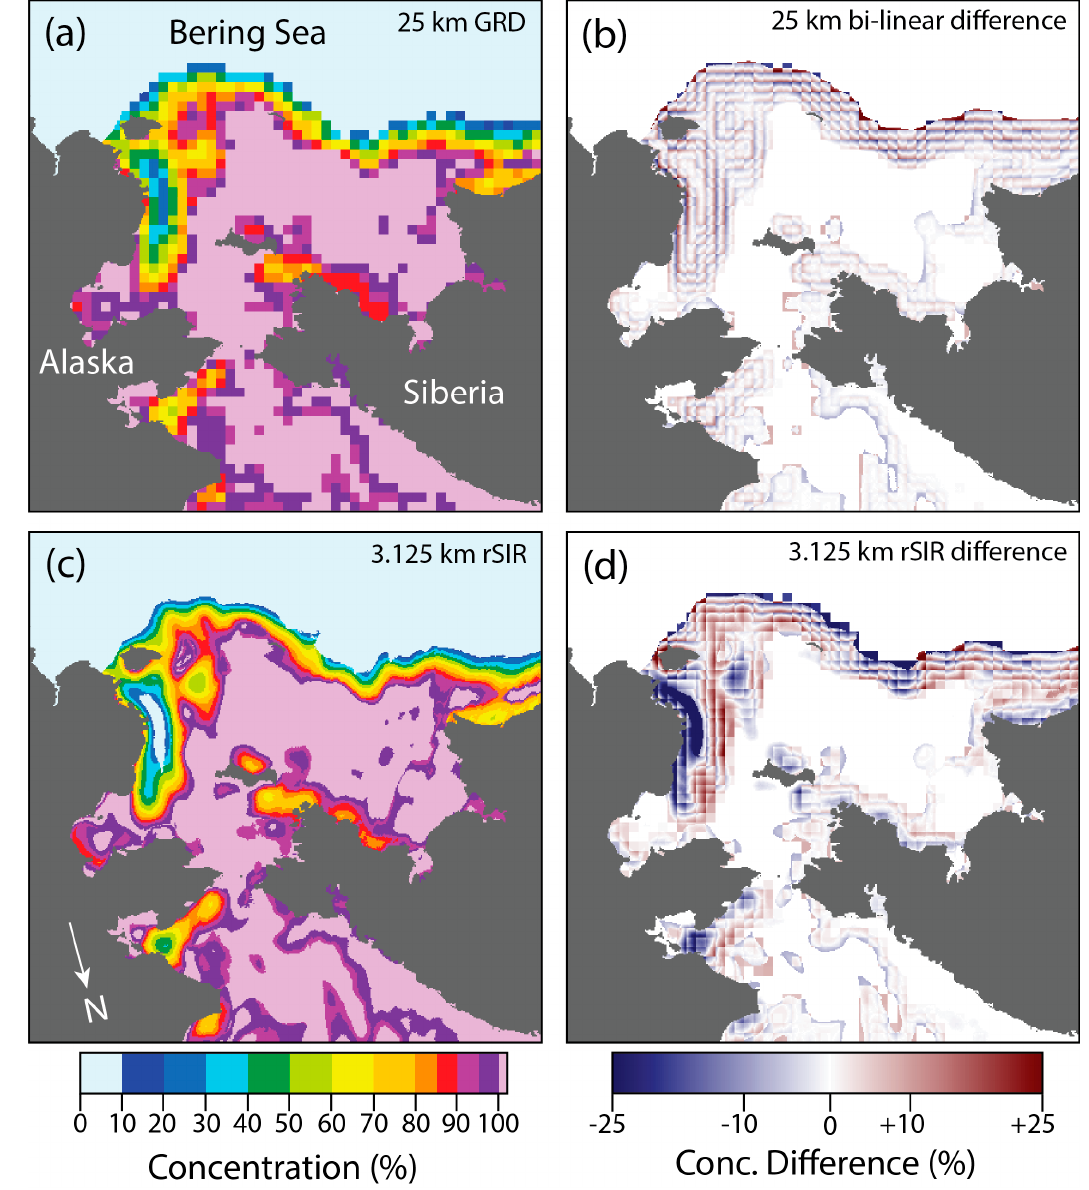
Figure 3. Bering Sea 1 March 2014 sea ice (a) 25 km GRD concentration, (b) of 3.125 km bi-linearly interpolated GRD minus 25 km GRD concentration difference, (c) 3.125 km rSIR concentration, and (d) 3.125 km rSIR minus 25 km GRD concentration difference.